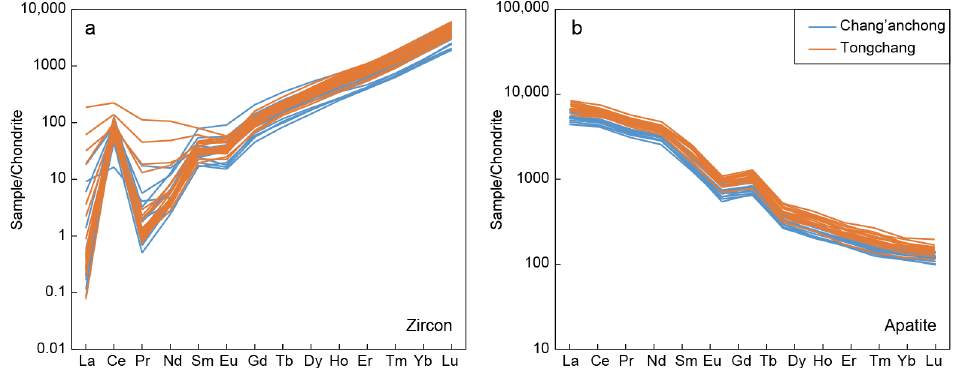
Figure 5. Chondrite-normalized REE patterns of ( a ) zircon and ( b ) apatite of Tongchang and Chang’anchong quartz syenite porphyries. Chondrite values are after [77].